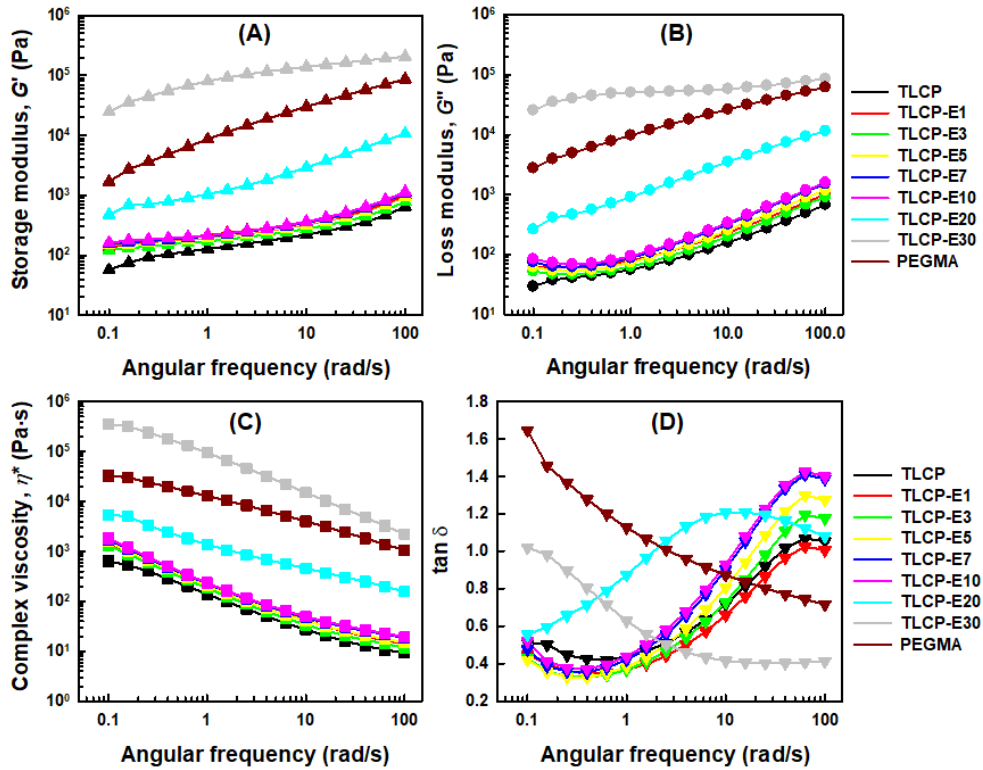
Figure 9. Changes of the ( A ) shear storage modulus ( G ’), ( B ) shear loss modulus ( G ”), ( C ) complex viscosity ( h *), and ( D ) loss tangent (tan δ ) of neat TLCP, PEGMA, and TLCP/PEGMA blends as a function of the angular frequency.